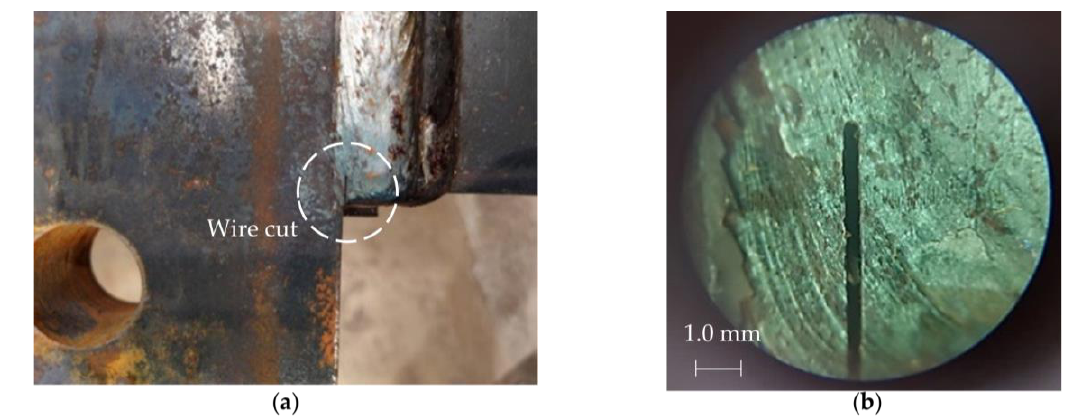
Figure 5. Tip radius of the wire-cut notch of the DTC specimen: ( a ) notch position and ( b ) magnified view.